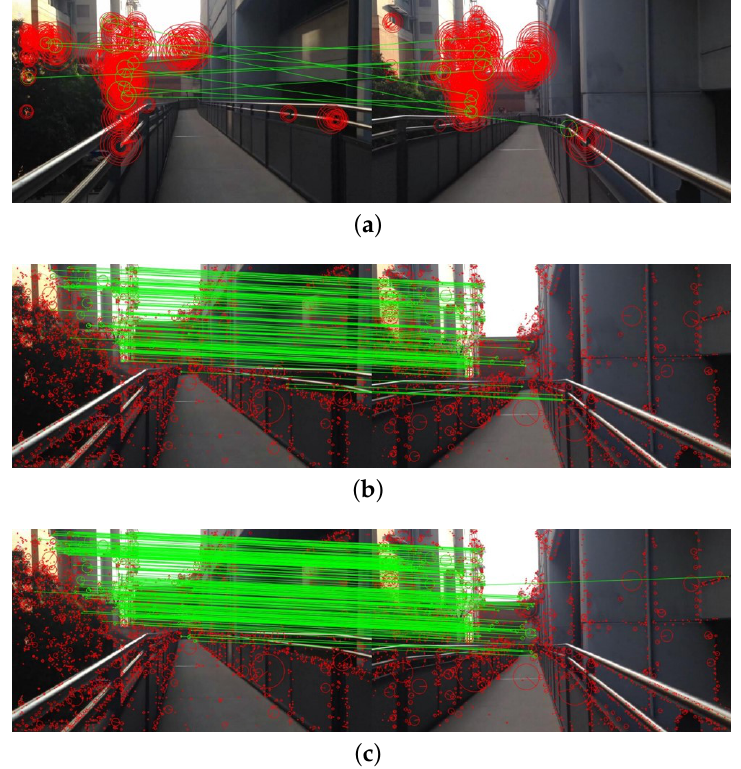
Figure 5. Comparison of matching results among ( a ) ORB descriptors, ( b ) SIFT descriptors, and ( c ) Geodesc